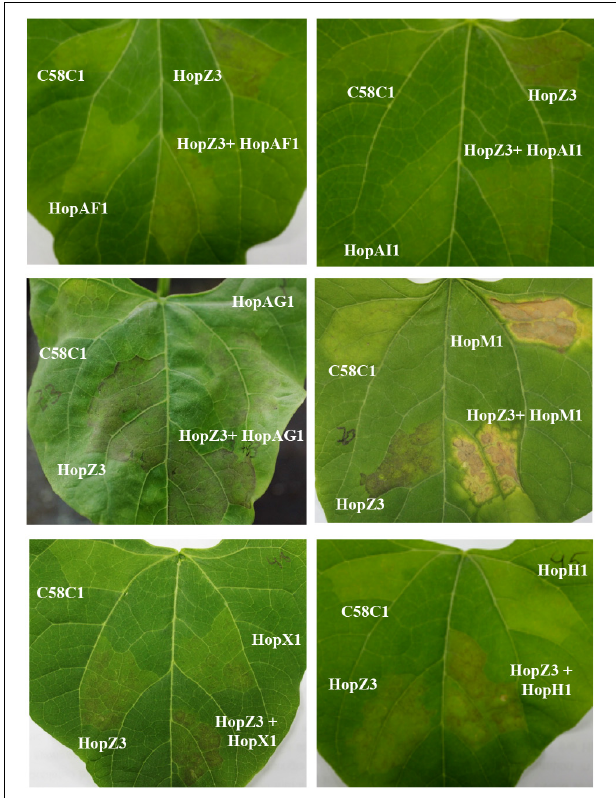
FIGURE 5 | Screening for putative suppressors of HopZ3-triggered immunity in bean. Plant response displayed in bean leaves 48 hours post-inoculation (hpi) with Agrobacterium tumefaciens C58C1 carrying binary plasmids containing the genes encoding the indicated effector. Where two effectors are indicated leaves were infiltrated with a 1:1 mixture of A. tumefaciens C58C1 carrying a binary plasmid containing the gene encoding each of the indicated effectors. Pictures were taken 48 hpi. The experiment was repeated at least five times with similar results.